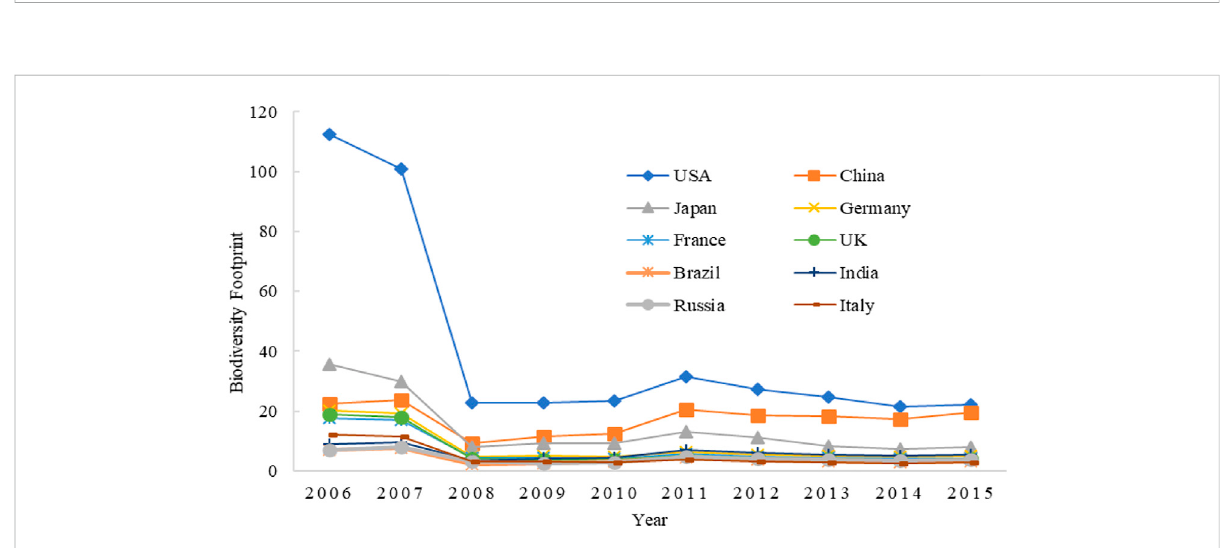
FIGURE 6 Time dynamic trend analysis of the net value of biodiversity import and export in the top ten countries of world